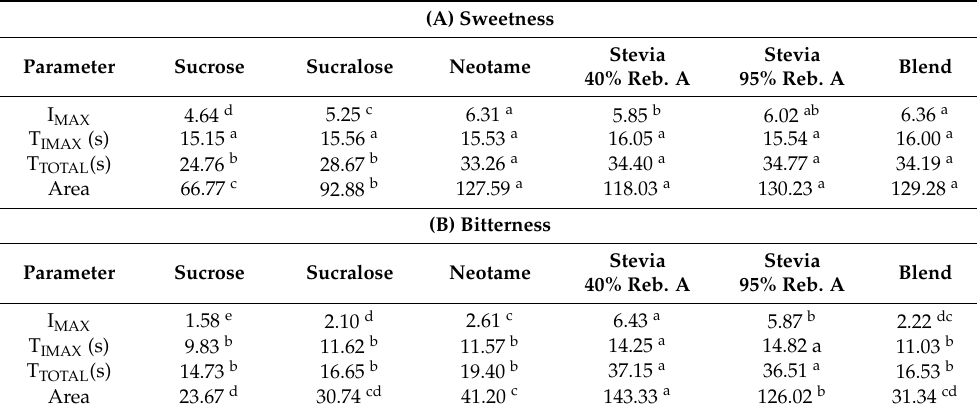
Table 4. Means * of parameters curves and standard deviation of the time–intensity analysis for sweetness (A) and bitterness